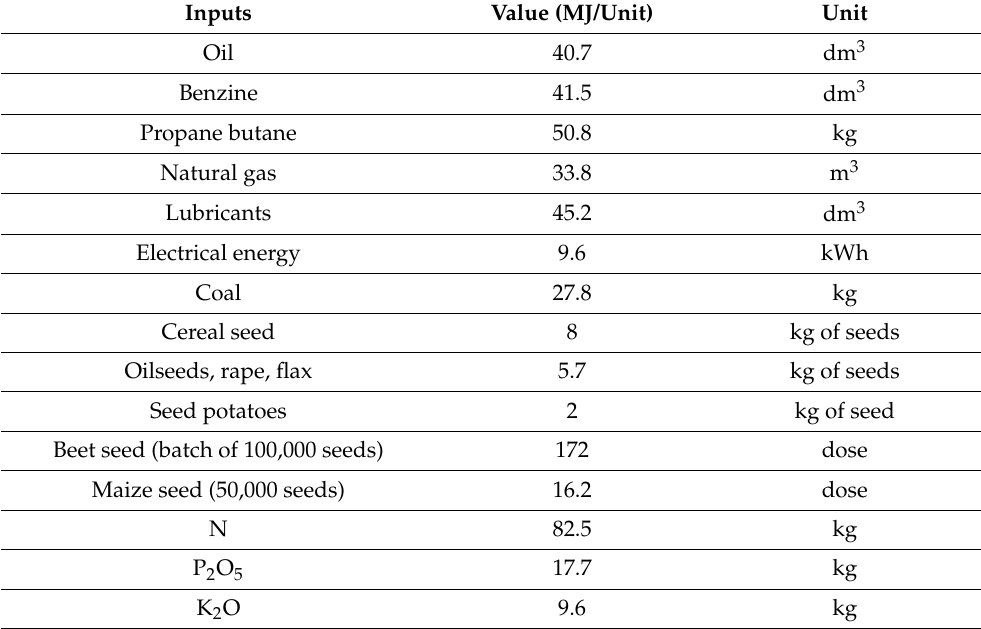
Table A4. Energy of used